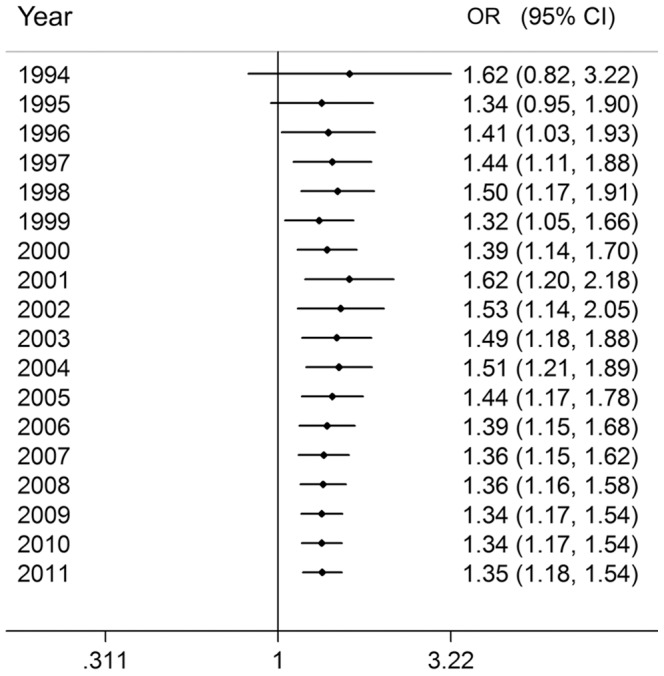
Results of the cumulative meta-analysis.The random effects pooled OR with 95% CI at the end of each information step is shown.